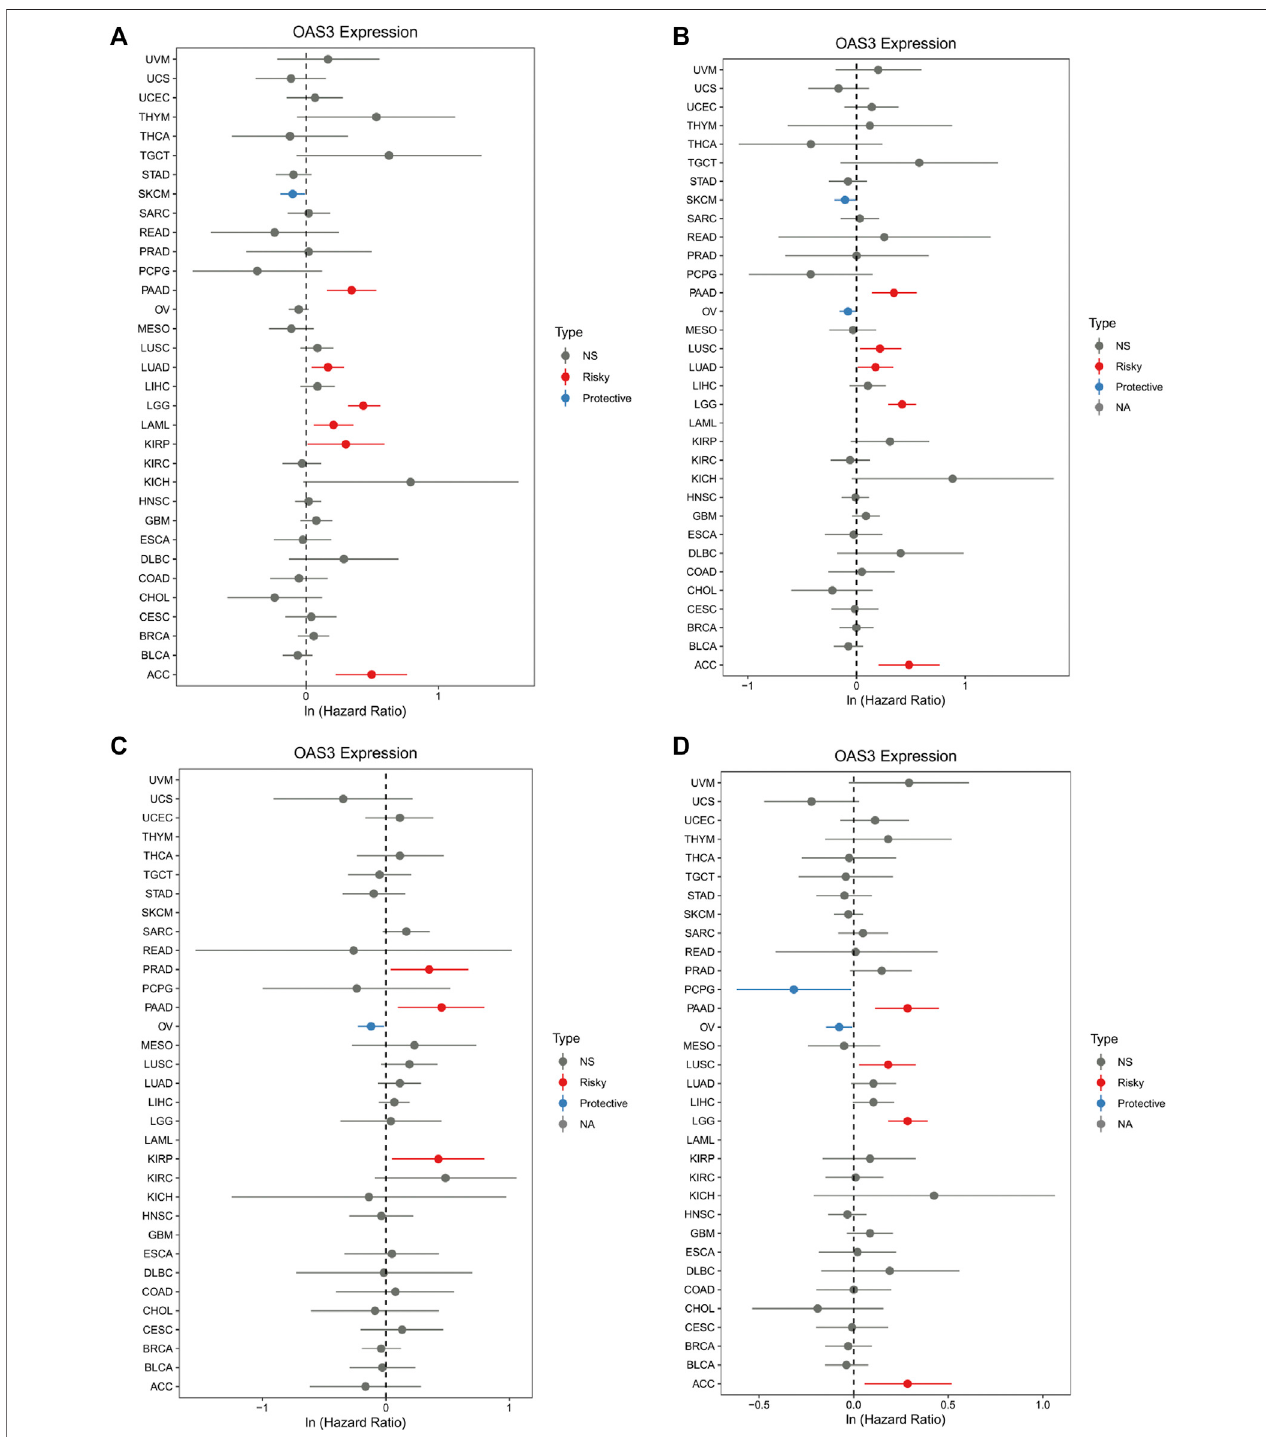
FIGURE 3 | Forest plot of the association of OAS3 expression with OS (A) , DSS (B) , DFS (C) , and PFS (D) . (A) : OAS3 is highly expressed in patients with PAAD, LUAD,LGG,LAML,KIRP,ASSwithpoorOS.InSKCM,highexpressionofOAS3isaprotectivefactorforOS. (B) :InPAAD,LUSC,LUAD,LGG,ACC,patientswithhigh OAS3 expression showed shorter DSS than those with low expression. in SKCM, OV, the opposite effect of OAS3 was observed. (C) : OAS3 was highly expressed in PAAD, PRAD, and KIRP patients with poor DFS. In contrast, in OV, high OAS3 expression was associated with longer DFS. (D) : Patients with high OAS3 expression in PAAD, LUSC, LGG, and ACC had shorter DFS than those with low expression. In PCPG, the opposite role of OAS3 was observed.